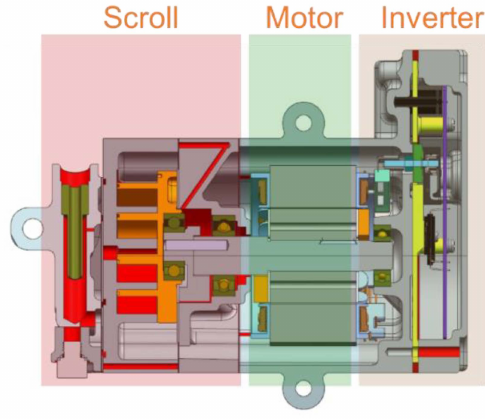
Figure 3. Structure of the electric compressor.